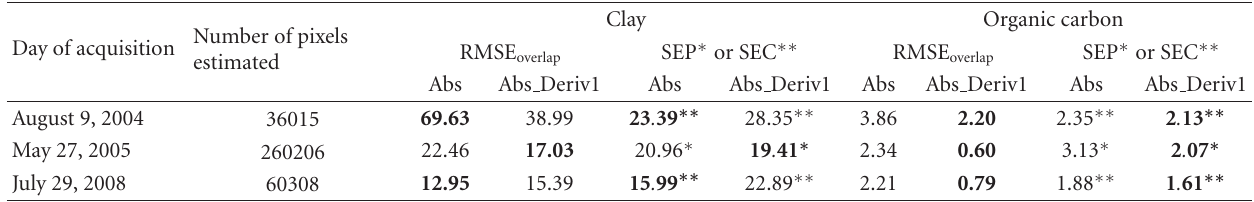
Table 8: Mean deviation (RMSE) of predicted clay and organic carbon contents in the overlap area of the HyMap flight strips and standard errors of PLSR models generated using the spectra transformed to absorbance (Abs) and spectra transformed to first derivative of absorbance (Abs Deriv1). Bold numbers indicate model parameters presented in Table